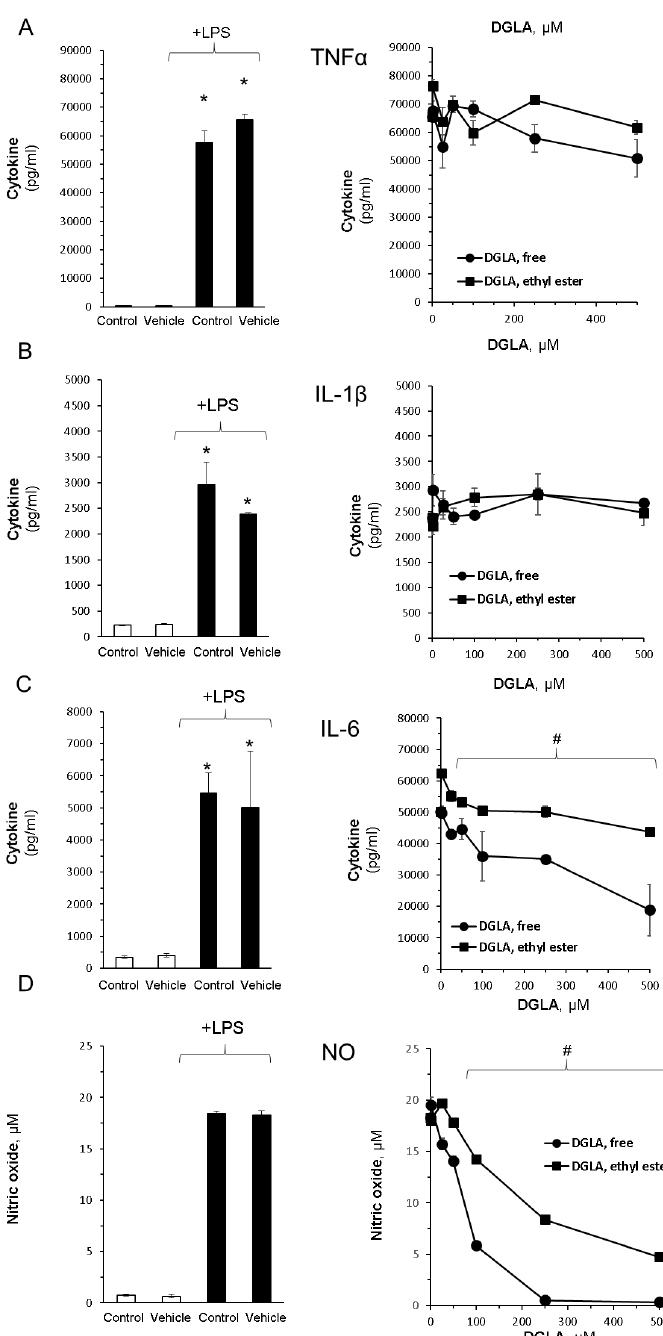
Figure 2. DGLA modulates key inflammatory signals in bacterial lipopolysaccharide (LPS)-stimulated RAW264.7 macrophages. Inflammation was induced by LPS (100 ng / mL). Concomitantly, the cells were treated without or with increasing DGLA concentrations. DGLA was administered as free acid or ethyl ester form for 24 h. Tumor necrosis factor α (TNF α ; ( A )), interleukin 1 β (IL-1 β ; ( B )); interleukin 6 (IL-6; ( C )), nitric oxide (NO; ( D )), and were quantified in culture supernatants after 24 h. Data are presented as mean ± SD. * / # denotes a significant di ff erence compared to untreated control or LPS-stimulated control, respectively, p < 0.05, n = 3. Control—untreated cells; vehicle—cells treated with 0.1% DMSO, the solvent used in DGLA preparations. The left panel depicts the impact of LPS stimuli and lack of e ff ect DMSO, whereas the right panel depicts the impact of increasing concentrations of DGLA on LPS-stimulated